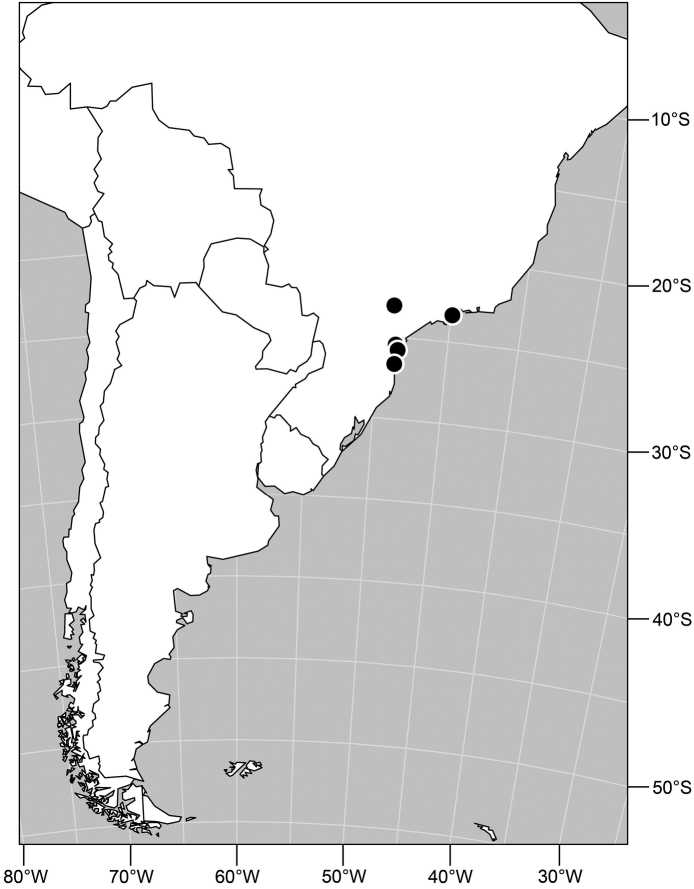
Distribution of Polytrichophora marinoniorum sp. n.